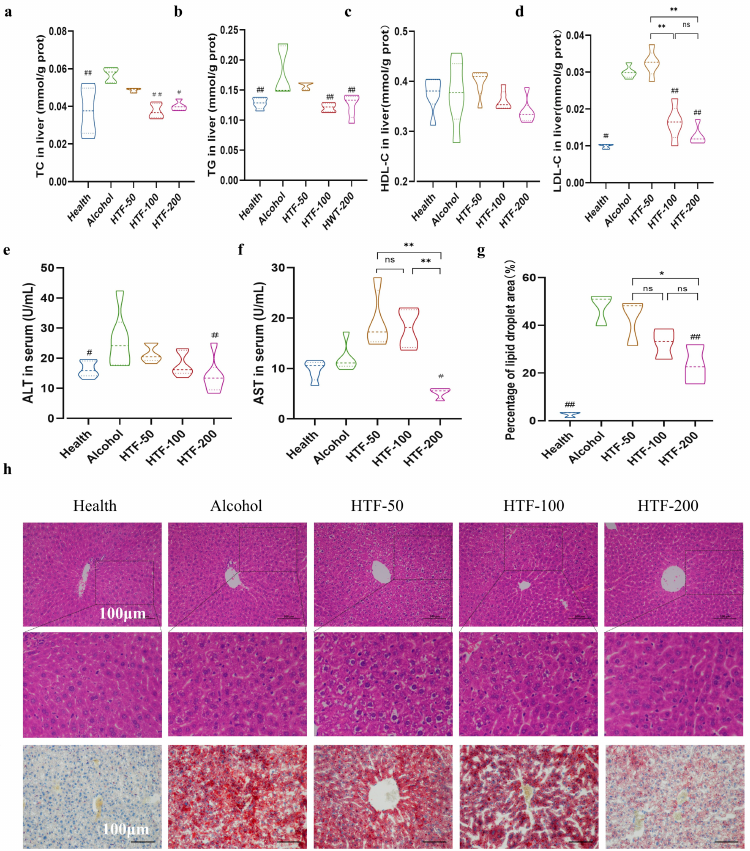
Figure 3. HTF reduced alcohol-induced lipid deposition in the liver. ( a ) Hepatic TC level. ( b ) Hepatic TG level. ( c ) Hepatic LDL-C level. ( d ) Hepatic HDL-C level. ( e ) Serum ALT level. ( f ) Serum AST level. ( g ) Percentage of lipid droplet area. ( h ) Histological examination of liver tissues. ( i ) The Oil Red O staining slice. Data are mean ± SEM. Significance was determined by one-way ANOVA corrected for multiple comparisons with Dunnett’s test. # p < 0.05 and ## p < 0.01 compared with alcohol group. ns, p > 0.05, * p < 0.05 and ** p < 0.01 compared with other HTF